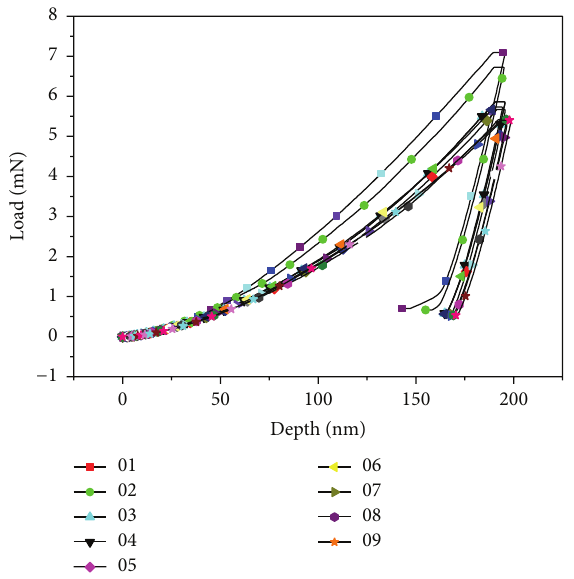
Figure 5: Load-depth curves at different positions.